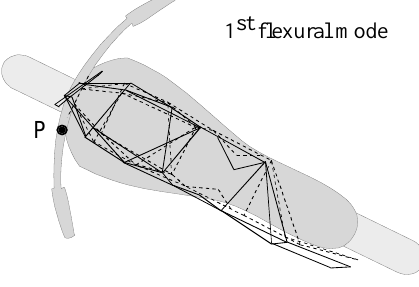
Fig. 9. Vehicle A, flexural mode, frequency 34.8 Hz, hysteretic damping 7.2%.